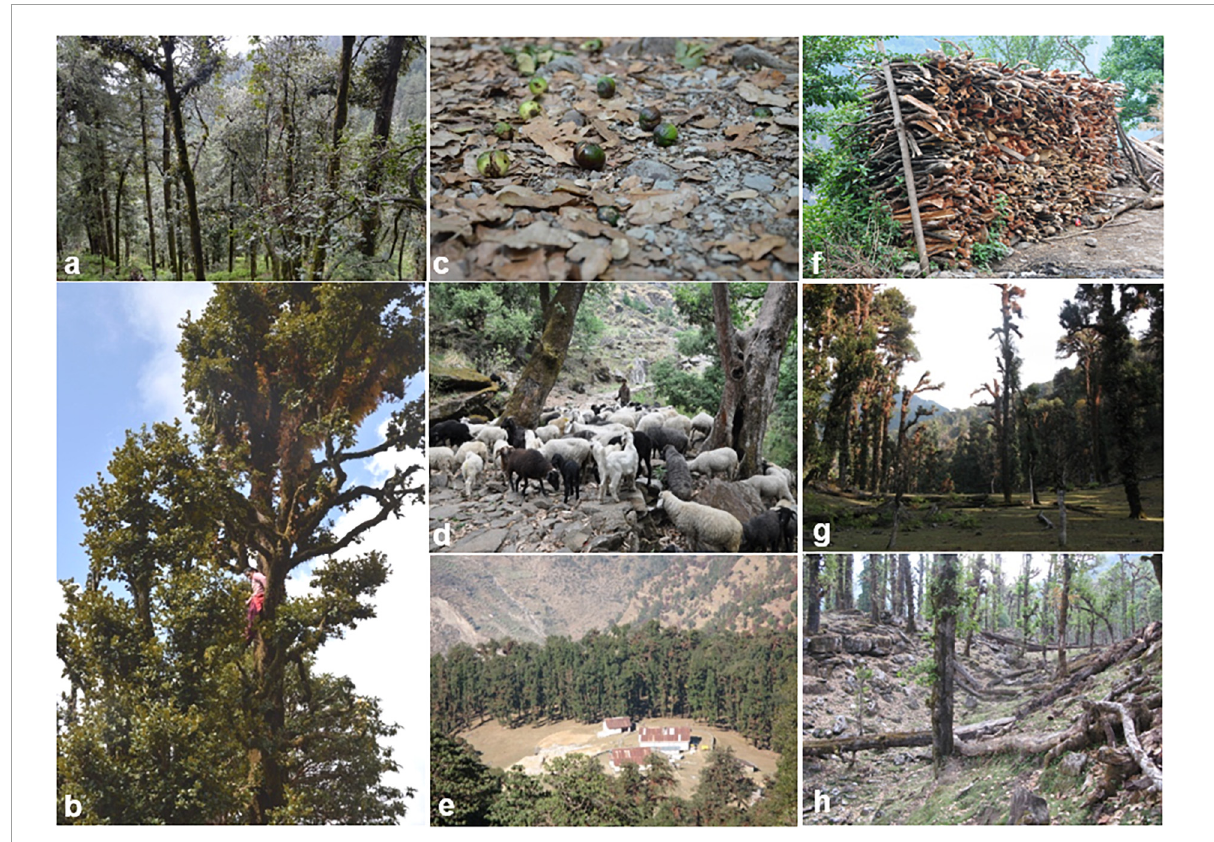
FIGURE2 Status of Quercus semecarpifolia forests under different use values and disturbance regimes; (a) dense forest; (b) anthropogenic pressure (cutting and lopping); (c) seed fall before maturity; (d) grazing by animals; (e) human encroachment (Dhakuri, Uttarakhand); (f) fuel wood collection; (g) forest degradation by human interference; and (h) naturally degraded forest.